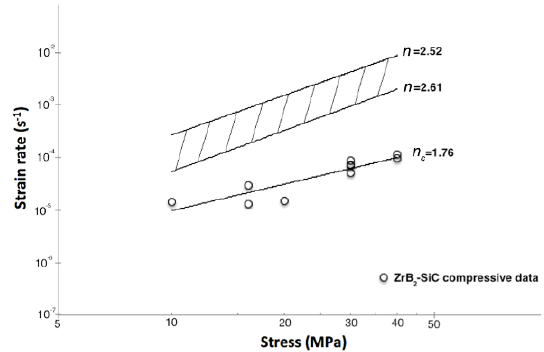
Fig. 5 Log–log plot of the compressive creep data for ZrB 2 –20% SiC at 1800 ℃ . Hatched region represents the predicted tensile region based on the “pinned” and predicted power law